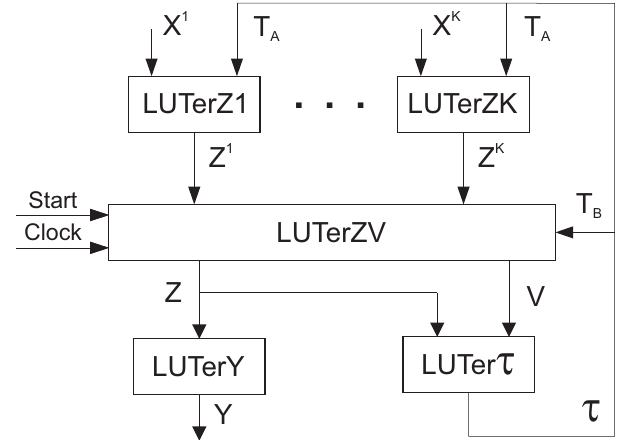
Figure 7. Structural diagram of LUT-based P C Z Mealy